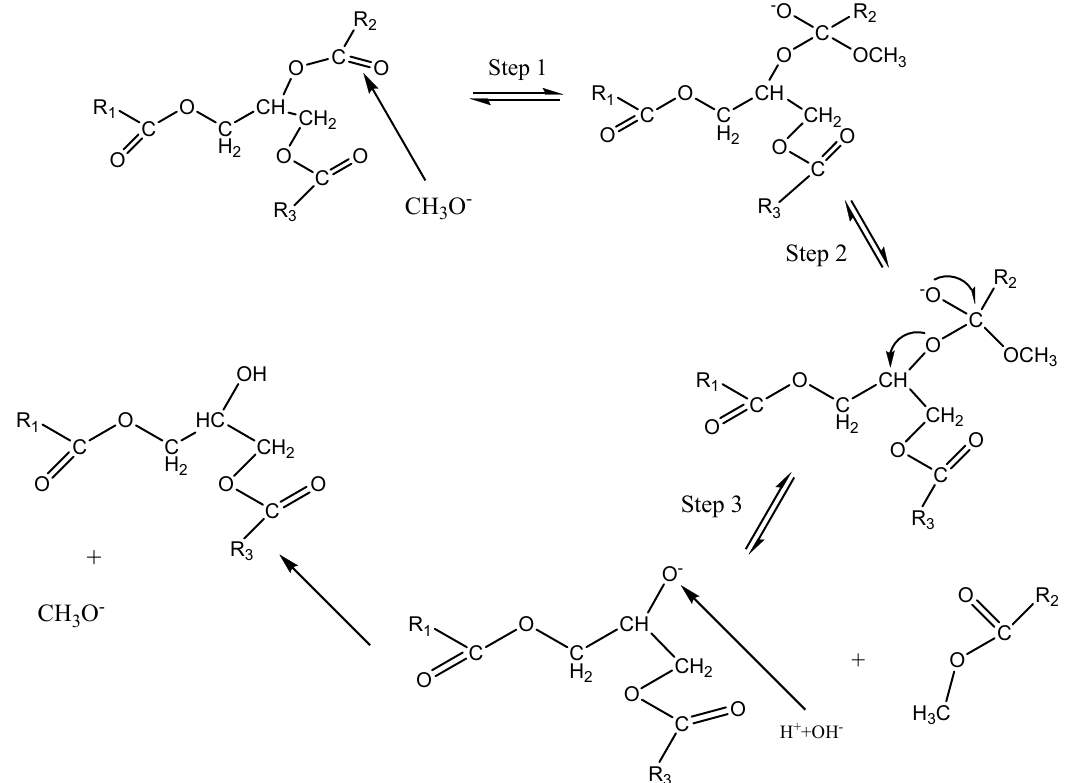
Figure 6. Biodiesel synthesis reaction mechanism.